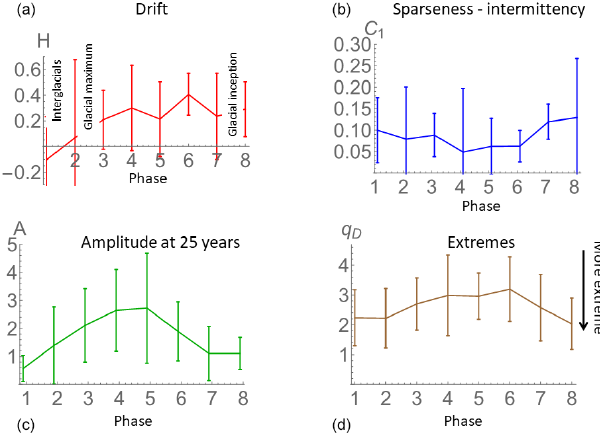
Figure 12. The fluctuation and intermittency exponents H and C 1 (a, b) are estimated over the range 500–3000years, as a func- tion phase with the standard deviations from the cycle-to-cycle vari- ability (all using non-dimensional time). Panel (a) ( H ) shows low drift in phases 1 and 2 but becomes driftier in the middle and older phases. The intermittency ( C 1 , b ) is moderate at the beginning and end of the cycles and a little weaker in the middle. Panel (c) shows the amplitude of the fluctuations at 25years determined by the stan- dard deviation of the dust flux (units: milligrams per square metre per year). We see that the flux has low amplitude fluctuations at the beginning and end of the cycles and 3–4 times higher amplitude fluctuations in the middle. Panel (d) shows the probability expo- nent q D estimated from the 25-year resolution data for each phase; the extreme 5% of the flux changes were used to determine the ex- ponent in each phase; the cycle-to-cycle spread is indicated by the error bars (overall average over the phases: q D = 2 . 62 ± 0 .